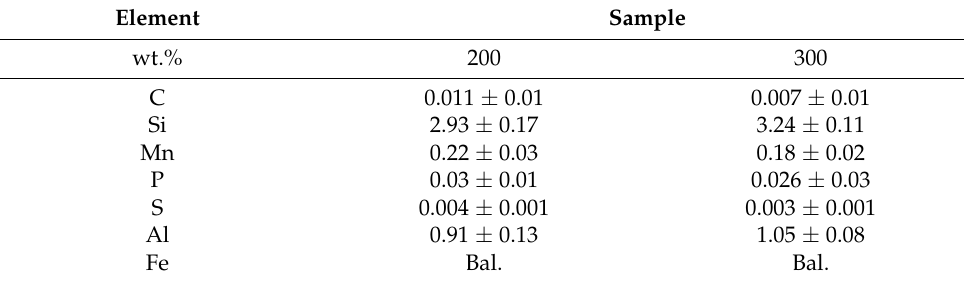
Table 1. Chemical composition of the tested